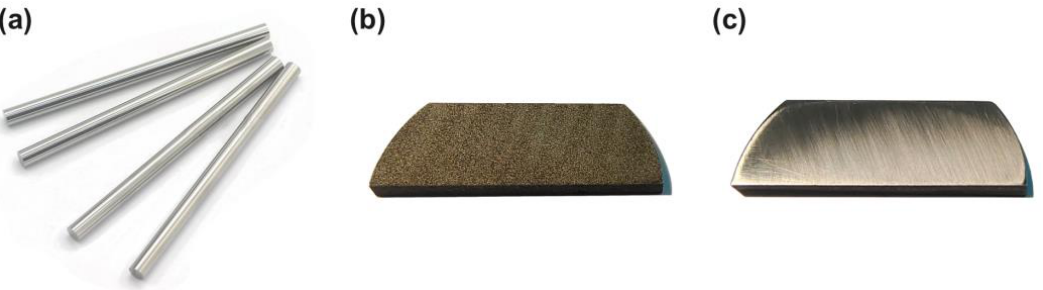
Figure 2. Experimental materials: ( a ) bar, ( b ) sheet (after wire cutting), ( c ) sheet (after grinding).